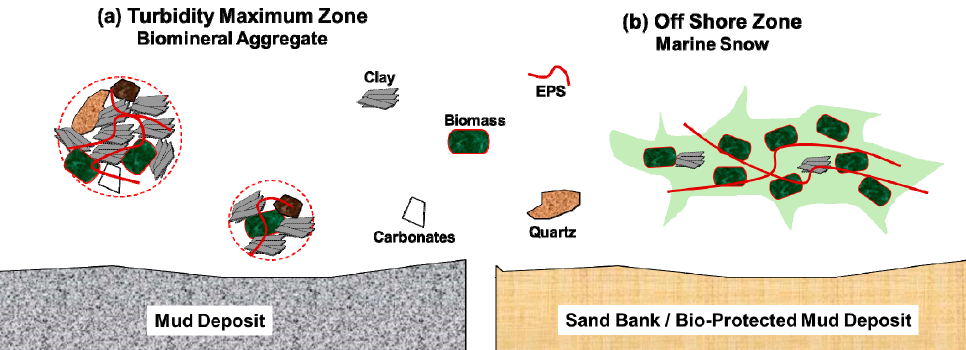
Figure 8. Schematic diagrams of ( a ) biomineral aggregates in the turbidity maximum zone (TMZ) and ( b ) biological marine snow in the offshore zone (OSZ). EPS: extracellular polymeric substances. Previous studies, carried out in the same TMZ, reported that large and settleable biomineral aggregates were dominant SPM species during bio-enriched spring and summer periods [31,32].